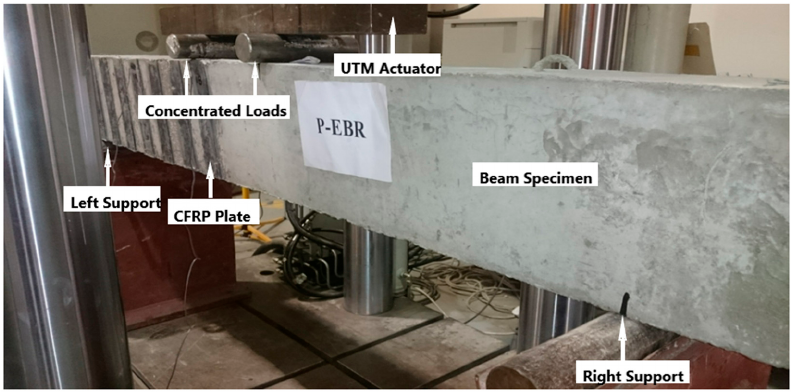
Figure 6. Test specimen mounted in the universal testing machine.